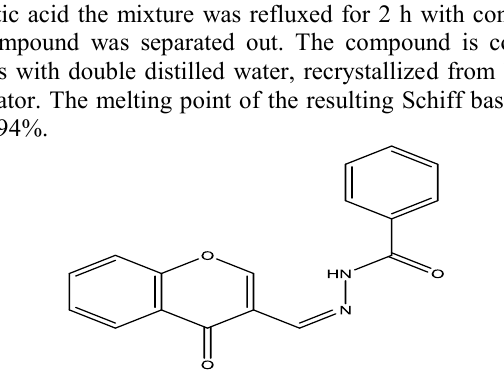
Figure 1. Proposed structure of schiff base ligand